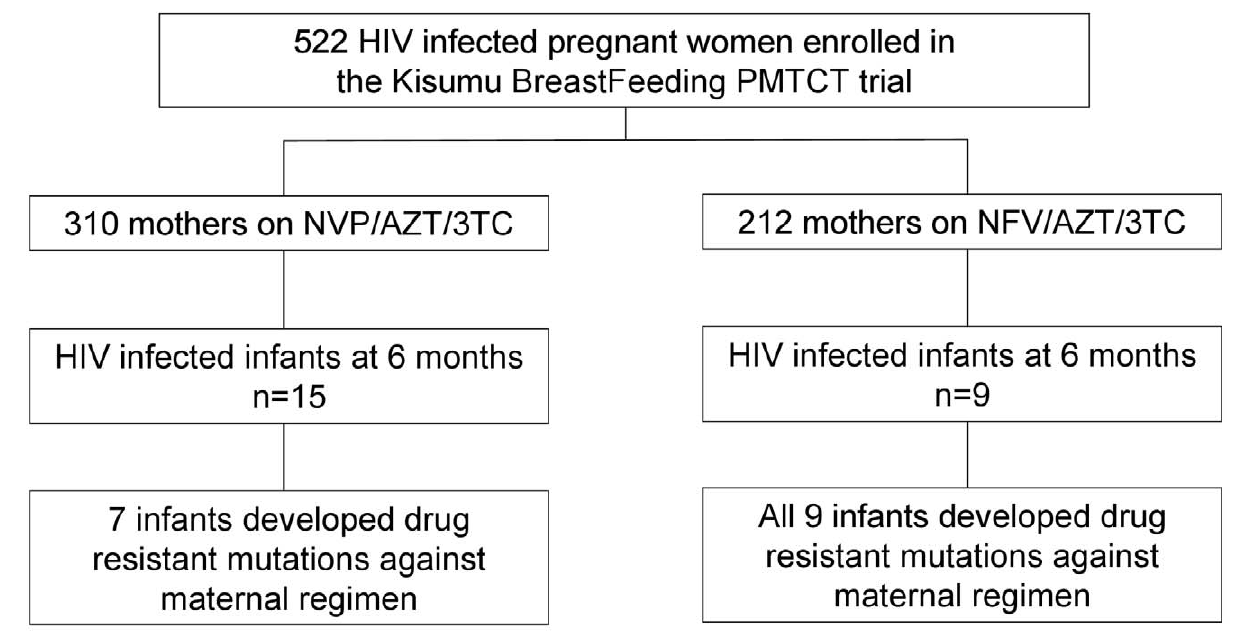
Figure 1. Cohort profile showing mothers enrollment, HIV transmission, and subsequent emergence of drug resistance in infants born to mothers in the NFV- and NVP-based regimens.